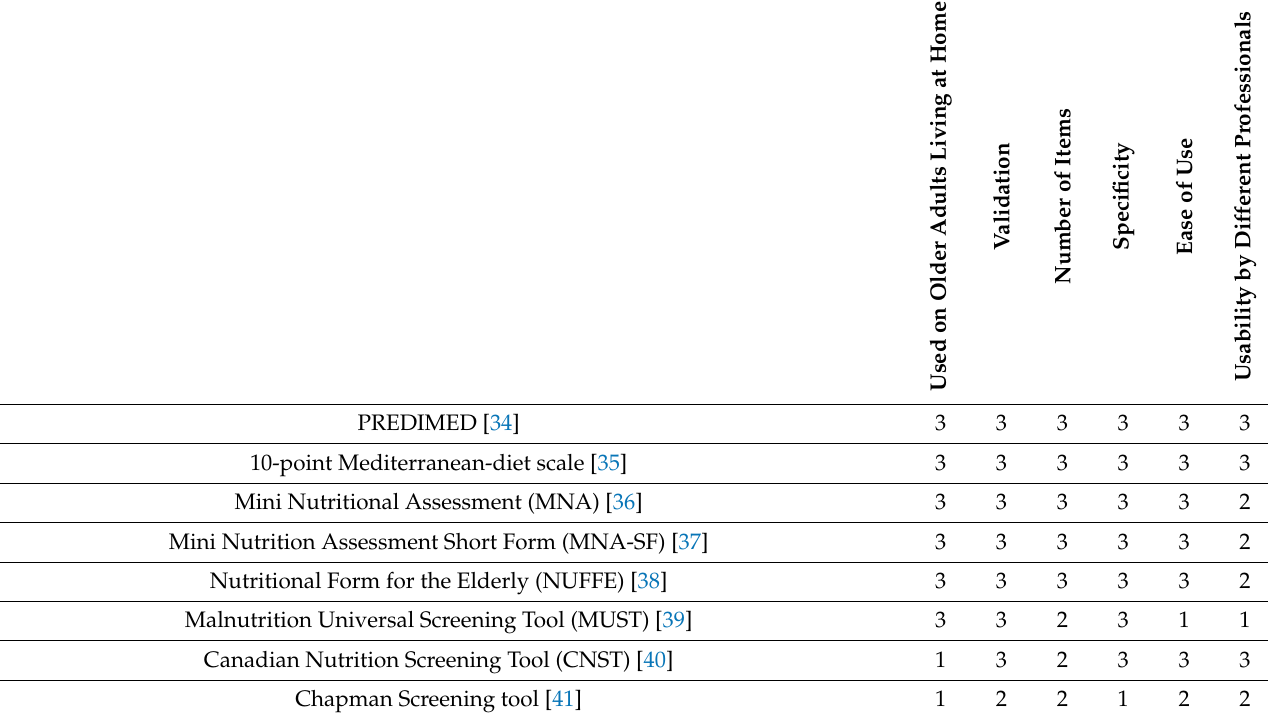
Table 3. Malnutrition assessment tools